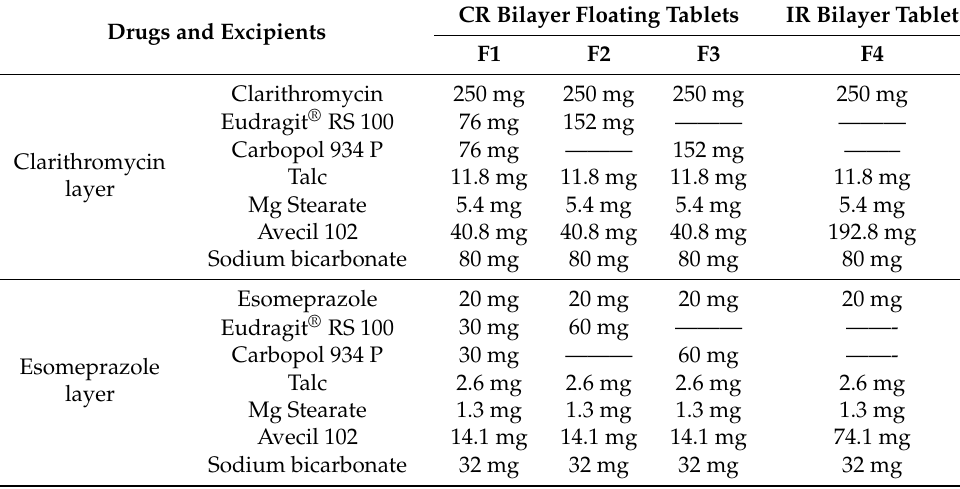
Table 1. Composition of tablets. Drugs and